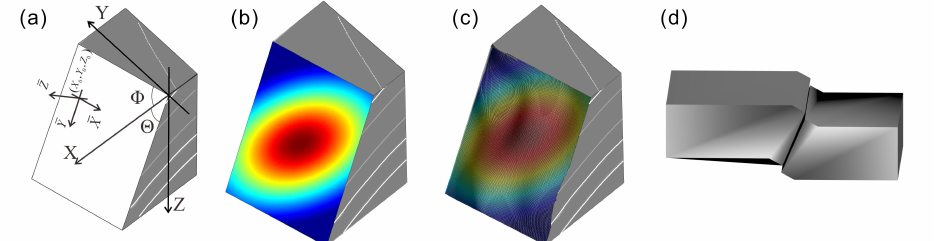
Figure 3. Four parts of virtual fault structures. ( a ) Reference plane. ( b ) Near-field displacement. ( c ) Fault surface. ( d ) Fault